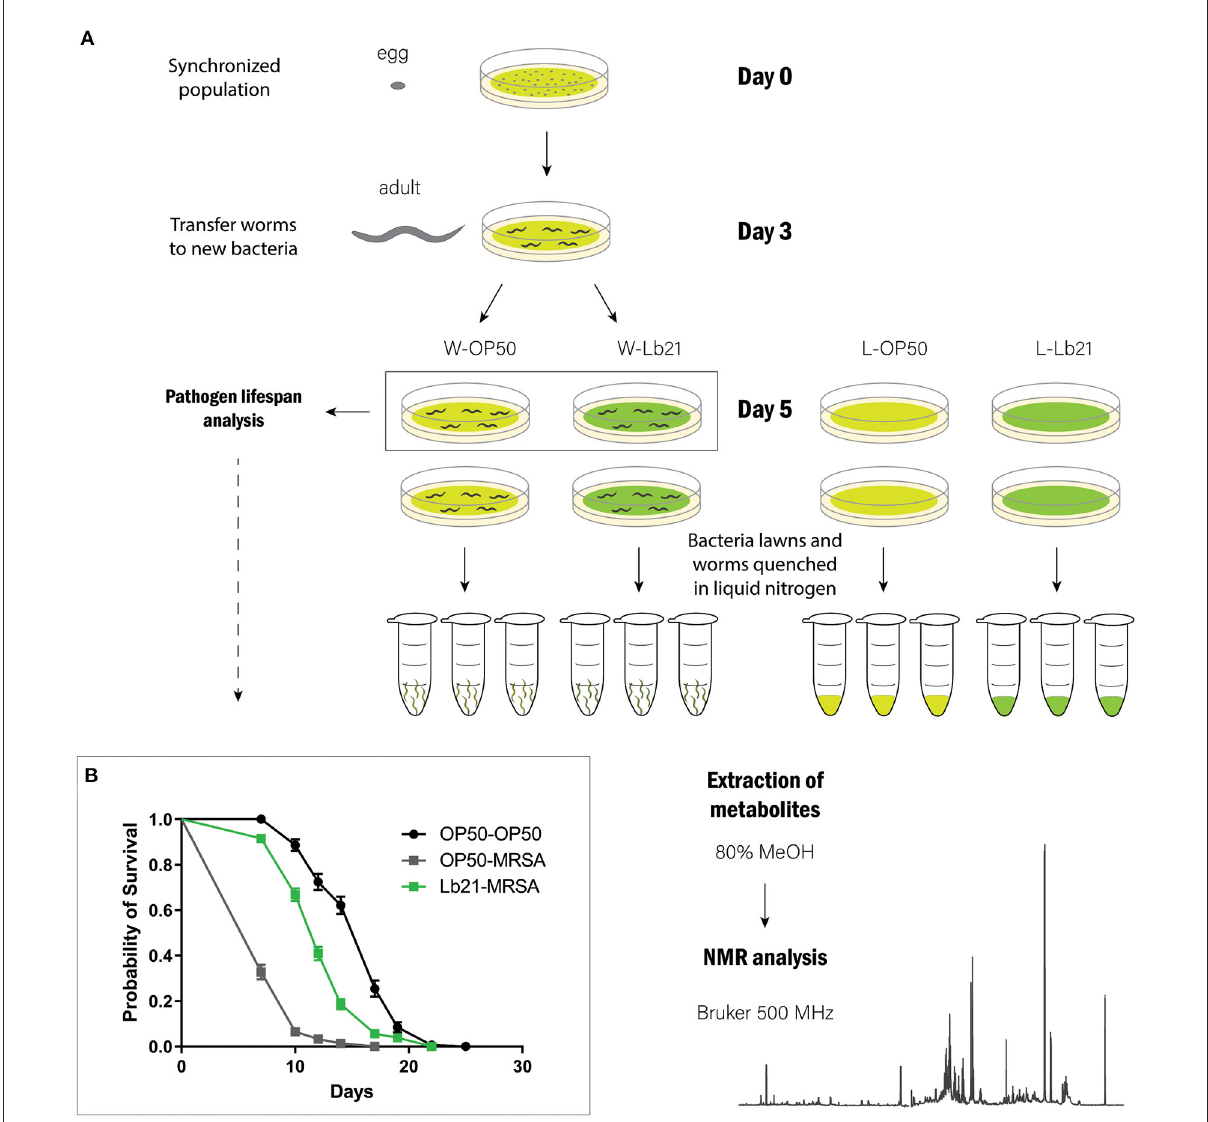
FIGURE1 Experimental design: (A) A synchronized population of rrf-3 worms was obtained by bleaching gravid adults. ∼ 500.000 eggs were distributed onto 225 large agar plates spotted with E. coli OP50 (UV irradiated for 30min) on day 0. On day 3, adult worms were transferred to E. coli OP50 or Lb21. On day 5, a subset of the worms was transferred to plates spotted with MRSA for pathogen resistance analysis. The remaining worms and bacterial lawns were prepared in triplicate to extract metabolites. (B) MRSA resistance analysis. Worms pretreated with Lb21 lived significantly longer ( p < 0.0001) than worms fed the standard OP50 bacteria when challenged with MRSA. Mean life span (days) of OP50-MRSA worms was 8.2 ± 2.0 ( n = 214) compared to 12.7 ± 3.4 ( n = 284) following Lb21 pretreatment.